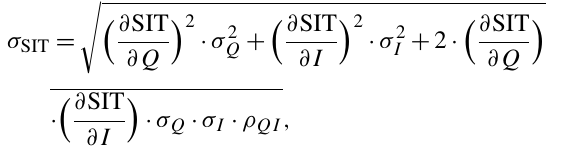
Figure 7. SIT retrieved as a function of the assumed SIT under dif- ferent SIC